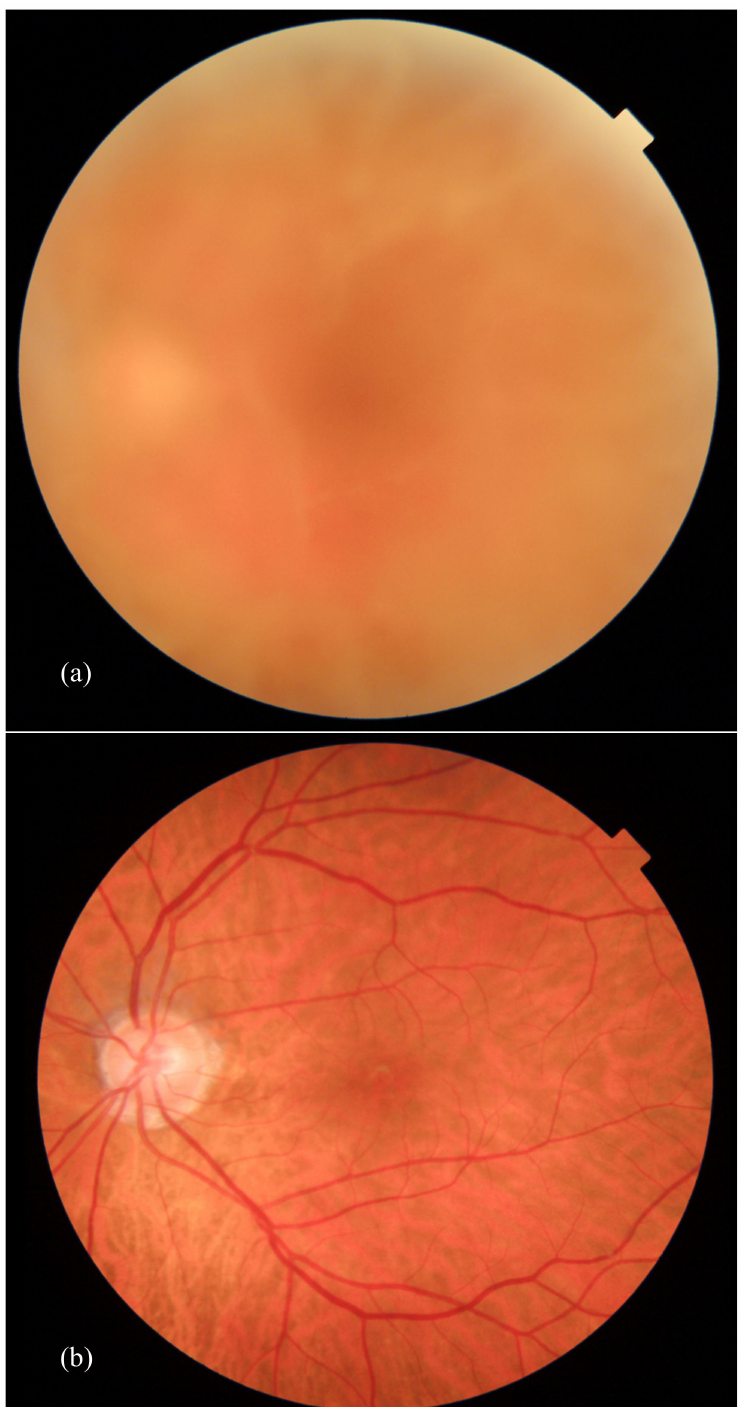
Figure 6. Fundus ophthalmoscopic examination before ( a ) and after ( b ) vitreoretinal surgery (50-degree angle of